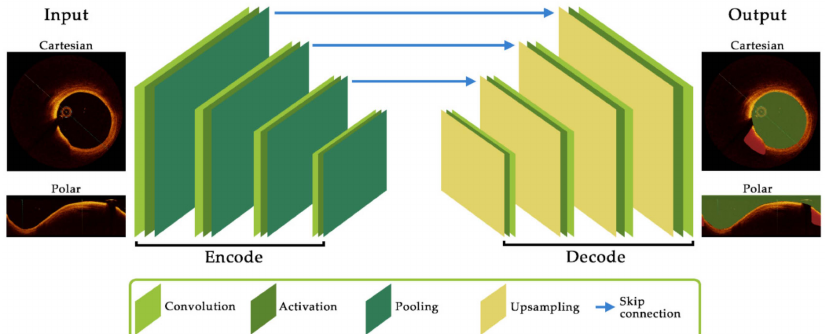
Figure 2. Schematic of key components and their layout for a convolutional neural network architec- ture. The encoder component consists of convolution and activation functions to extract feature maps before pooling (downsampling) to the subsequent layer. The decoder up-samples feature map data before further convolutions. Skip connections allow feature map data to be passed between layers which can assist in reducing resolution degradation between layers and is a critical feature of the popular U-Net architecture.